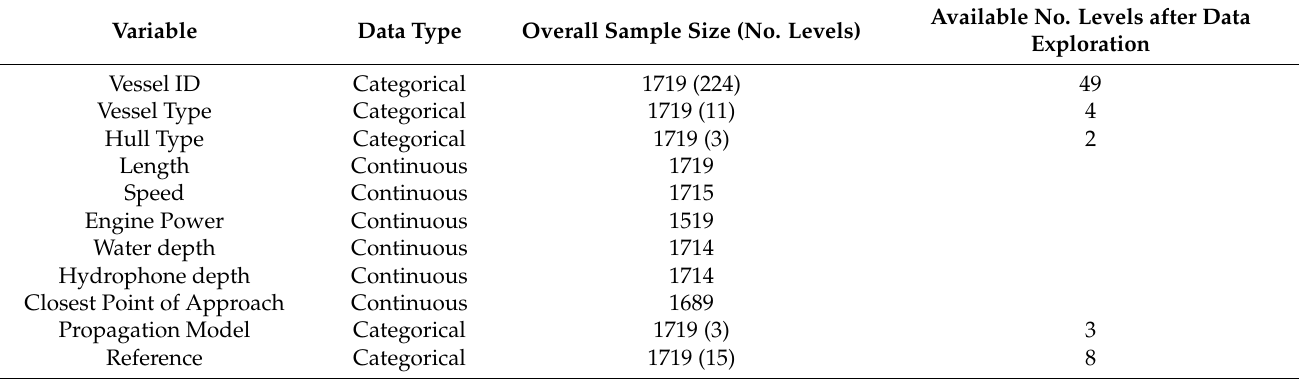
Table 3. Available variables and their measured or calculated units to include into the model, including available sample sizes and number of categorical levels gathered from published data (raw data only included), and sample sizes and number of categorical levels included in the final model.